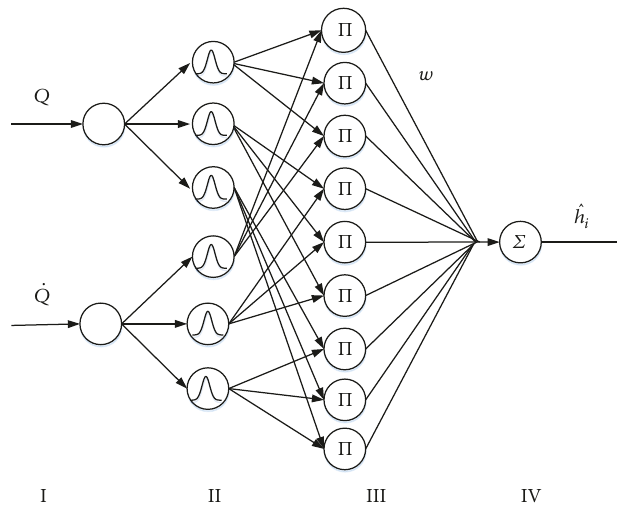
Figure 2: The con fi guration of the fuzzy neural